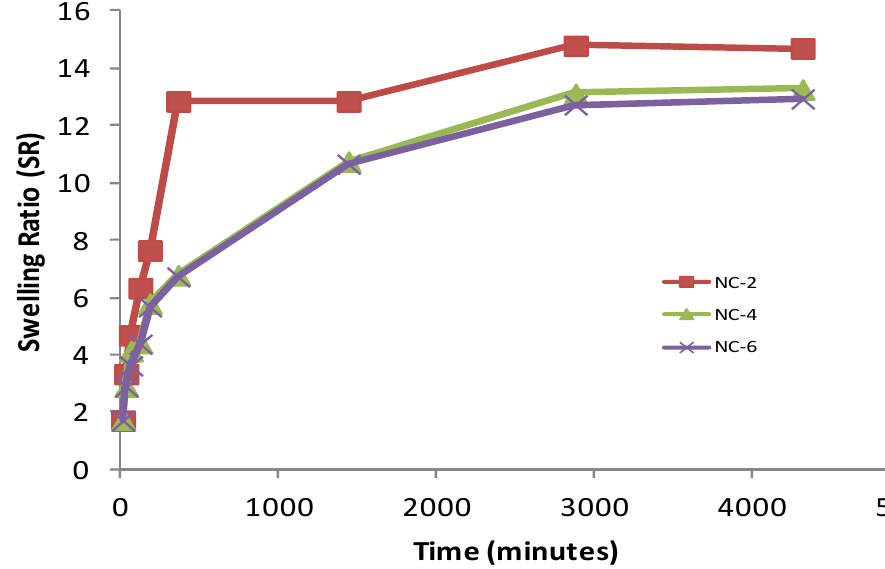
Figure 10. Effect of Cloisite 30B content on SR of various NCHs in phosphate ‐ buffered saline, pH 4.0. Figure 10. E ff ect of Cloisite 30B content on SR of various NCHs in phosphate-bu ff ered saline, pH 4.0. Gels 2019 , 5 , 44